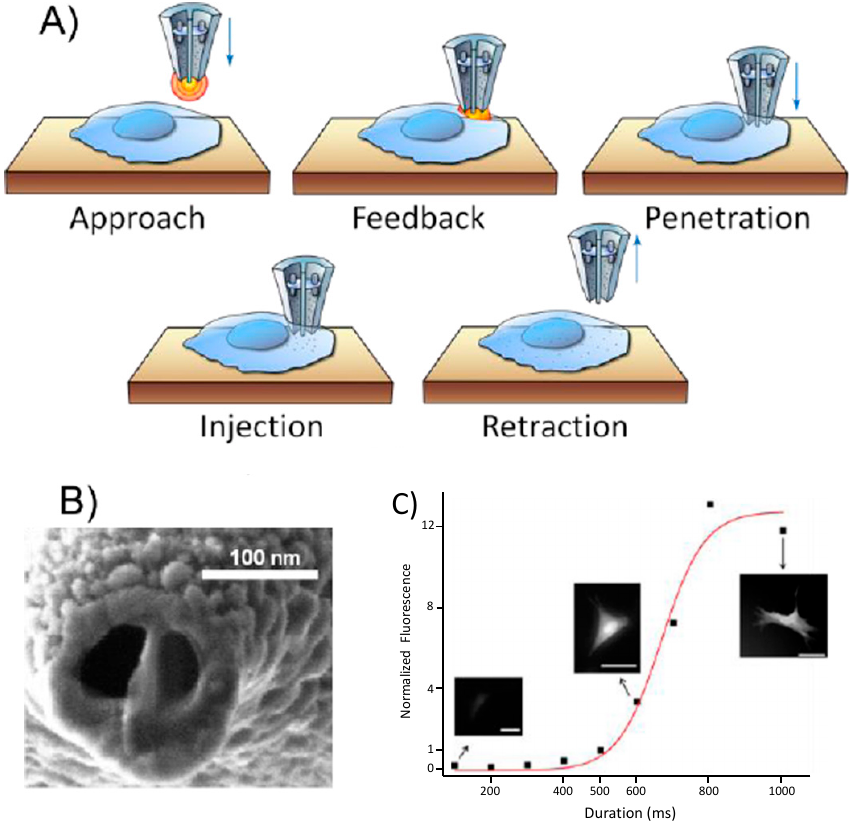
Figure 1. ( A ) Schematic representation of cell-surface detection by a double-barrel nanopipette; ( B ) SEM image shows the gold-sputtered double-barrel nanopipette; ( C ) Injection of carboxyfluorescein into human fibroblasts. The fluorescence intensity was normalized to that measured at 500 ms. Applied voltage: 10 V, scale bars 50 μ m. The red curve is a sigmoidal fit to the experimental data points. (Reproduced from [27] with the permission of the Royal Society of Chemistry).